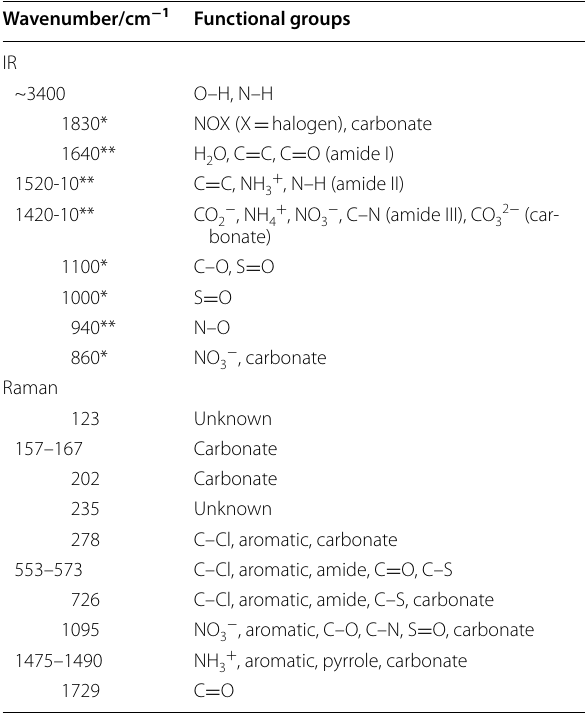
Table 1 Tentative peak assignments for the IR and Raman spectra based on Socrates